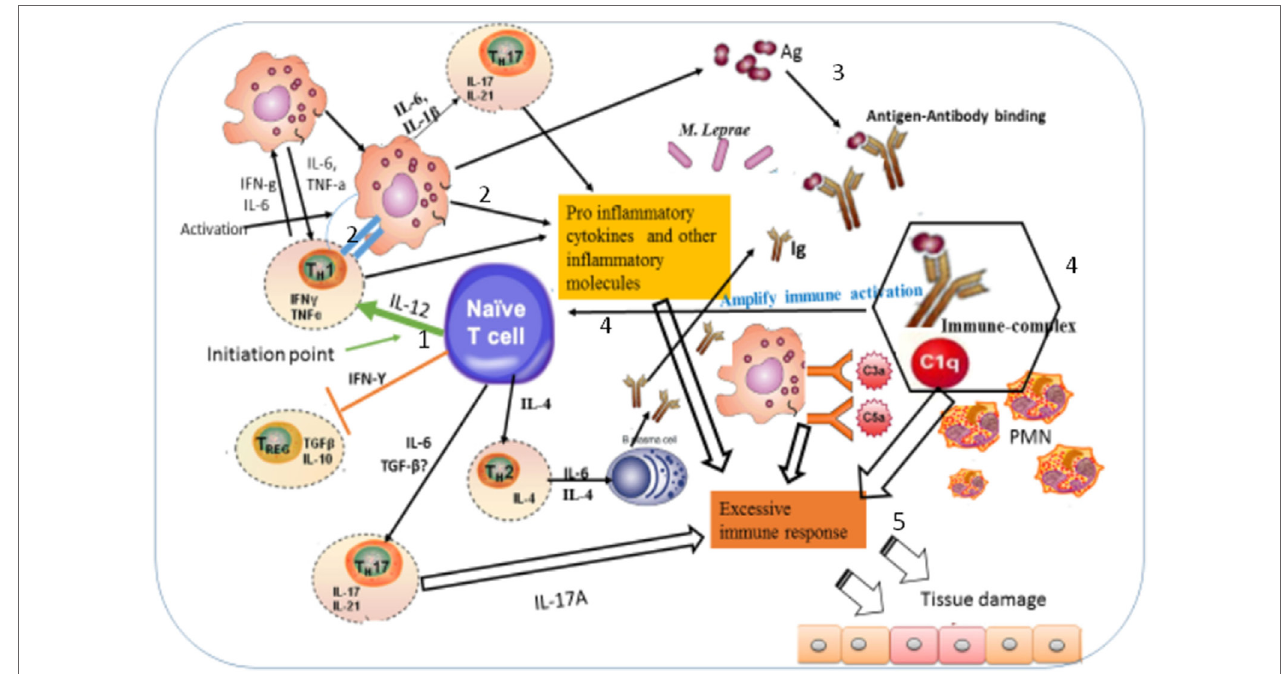
FigUre 9 | Illustration of the possible immunopathogenesis of erythema nodosum leprosum (ENL) based on the present findings. Based on the finding of this study, the immunopathogenesis of ENL can be illustrated using the following key steps: (1) spontaneous activation of T-cells leading to activation of macrophages that are already loaded with intact Mycobacterium leprae . Then, the activation of macrophages produces three key events: processing M. leprae and releasing of the processed antigens; antigen presentation to Th1 and production of pro-inflammatory cytokines such as IFN- γ and TNF- α and other inflammatory molecules. The causes of spontaneous T-cell activation should be investigated in the future. (2) Antigen presentation to Th1 stimulates Th1 to produce chemokines, which recruits macrophages to the site of antigen deposition, pro-inflammatory cytokines (IFN- γ , TNF- α ), and other inflammatory mediators that increase expression of vascular adhesion molecules. (3) The processed and released antigens bind to the presynthesized antibody leading to antigen–antibody complex formation, which in turn recruits C1q complement and hence immune-complex formation. Following the immune-complex formation, neutrophils will be recruited to the site of immune- complexes. (4) Once immune-complex is formed, it amplifies the immune response which leads to aggressive antigen presentation, immunoglobulin synthesis, and activation of other inflammatory T-cells. (5) The pro-inflammatory cytokines and other inflammatory molecules released from macrophages, Th17, and Th1 and the immune-complex formation beyond clearance lead to tissue damage as sketched